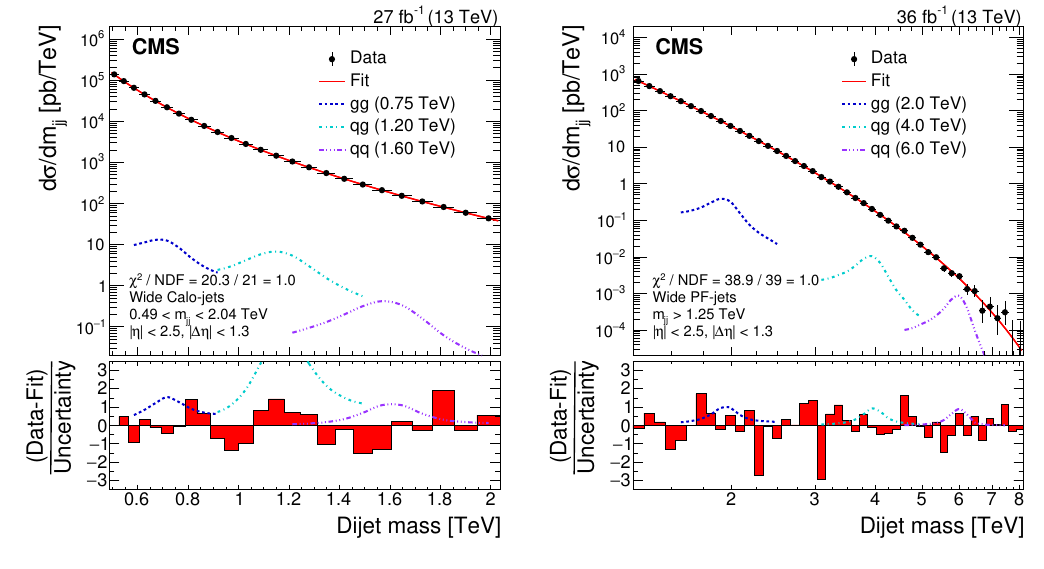
Figure 7 . Dijet mass spectra (points) compared to a (cid:12)tted parameterization of the background (solid curve) for the low-mass search (left) and the high-mass search (right). The horizontal lines on the data points show the variable bin sizes. The lower panel in each plot shows the di(cid:11)erence between the data and the (cid:12)tted parametrization, divided by the statistical uncertainty of the data. Examples of predicted signals from narrow gluon-gluon, quark-gluon, and quark-quark resonances are shown with cross sections equal to the observed upper limits at 95%